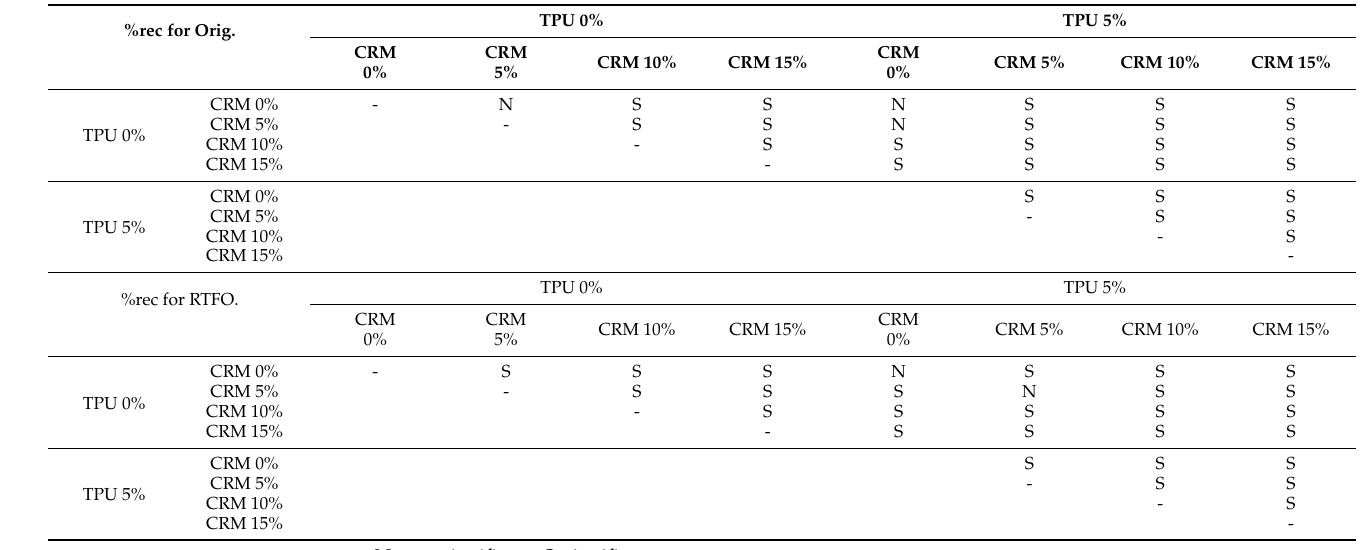
Table 8. Statistical analysis results of the %rec as a function of CRM contents and the addition of TPU ( α =